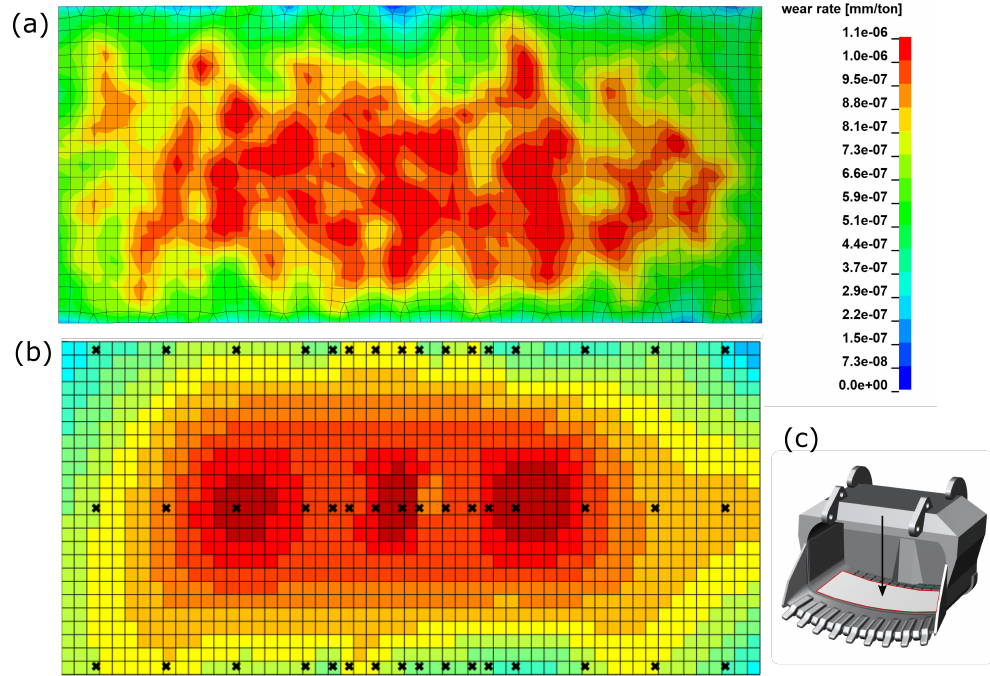
Figure 18. Figures showing the simulated ( a ) and experimental ( b ) wear rate. The wear maps are located at the bottom of the bucket ( c ). The lower parts of the wear maps correspond to the inlet of the bucket. The black markers in ( b ) correspond to the positions of the experimental measurements. The color plots are in units